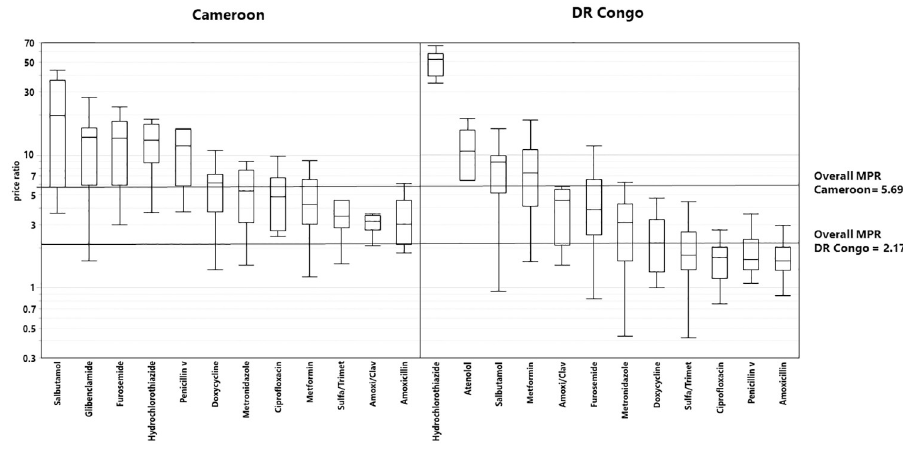
Fig 4. Boxplots of the price ratios of the collected medicines sorted by API and